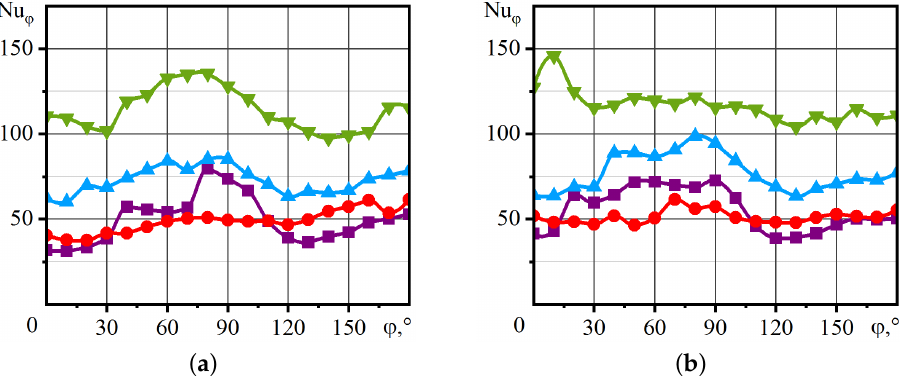
Figure 10. Distribution of the local Nusselt number over the second cylinder: ( a ) S = d and ( b ) S = 2 d (purple curve—Re = 2.4 × 10 3 ; red curve—Re = 4.8 × 10 3 ; blue curve—Re = 9.6 × 10 3 ; green curve—Re = 29.8 × 10 3